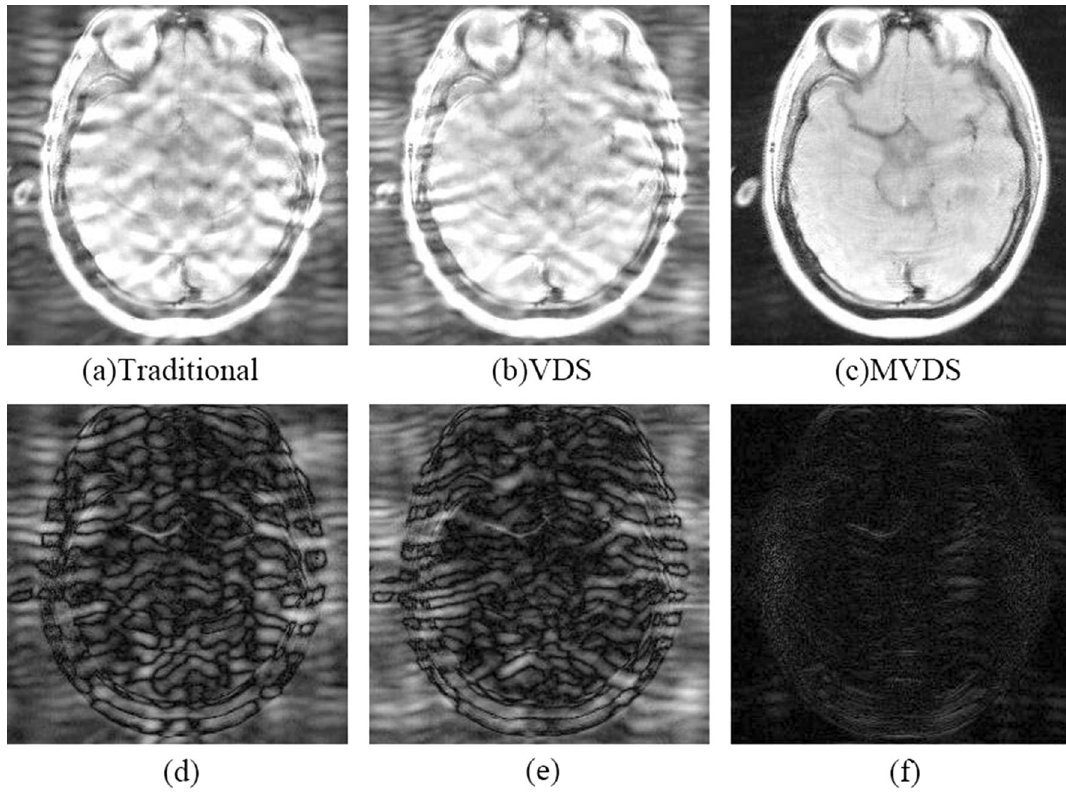
Figure 2. When R = 4 and ACS = 16, use NL-GRAPPA to reconstruct the image to compare traditional, VDS and MVDS methods. ( a ) The traditional method, and ( d ) is the difference graph. ( b ) The VDS method, and ( e ) is the difference map. ( c ) The MVDS method, sampled 20 lines of data with ORF = 2, and ( f ) is the difference graph. Due to the lack of ACS, the performance of the VDS method is worse. The kernel sizes are 15 × 2.